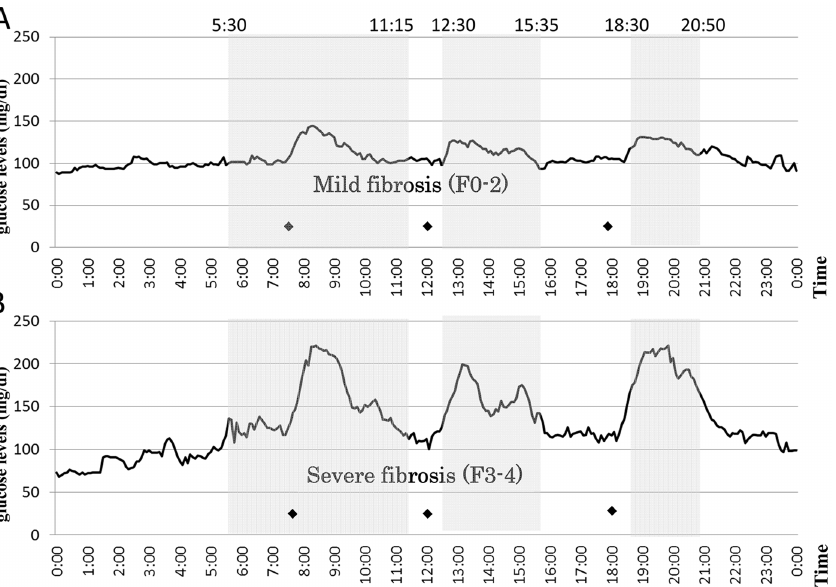
Figure 4. Twenty-four-hour sensor glucose profiles by continuous glucose monitoring system. The changes in the median sensor glucose levels during 24 hours are shown in the patients with A) mild fibrosis (F0–2, n =10) and B) severe fibrosis (F3–4, n =10). The variability of median glucose levels among the patients with mild fibrosis was remarkably smaller than that among the patients with severe fibrosis. Median glucose levels in the patients with severe fibrosis were higher than those with mild fibrosis (shadows areas, P , 0.05 to P , 0.001). Black diamond: Time of meal consumption.